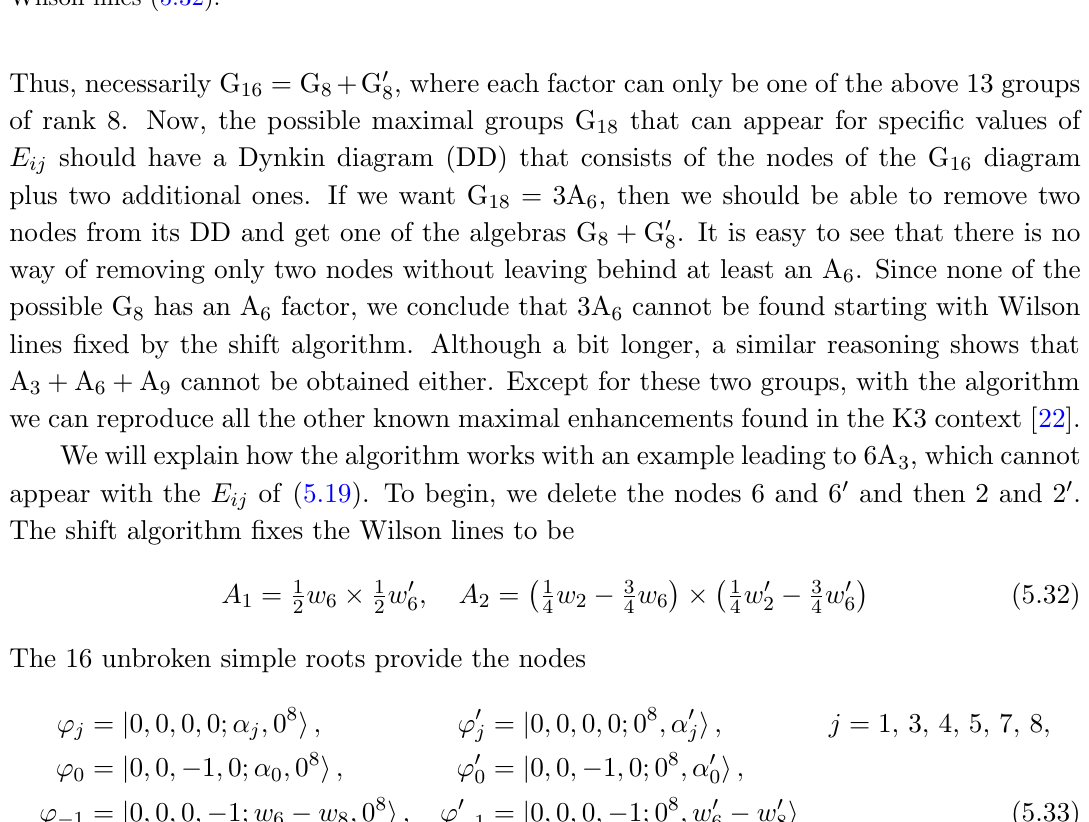
Figure 12. Dynkin diagram corresponding to the 16 simple roots that survive the breaking by the Wilson lines